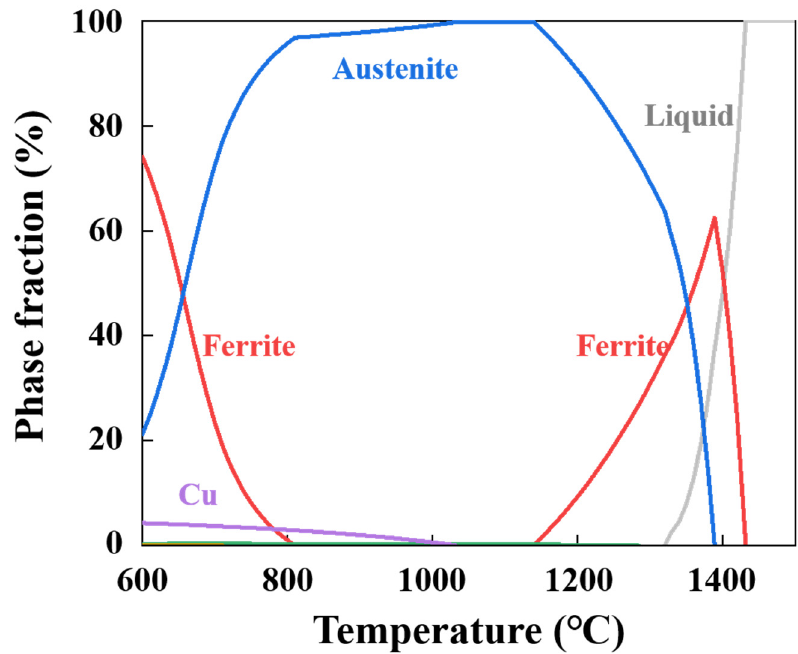
Figure 9. Equilibrium phase diagram of 17-4 PH SS calculated by JMatPro software.